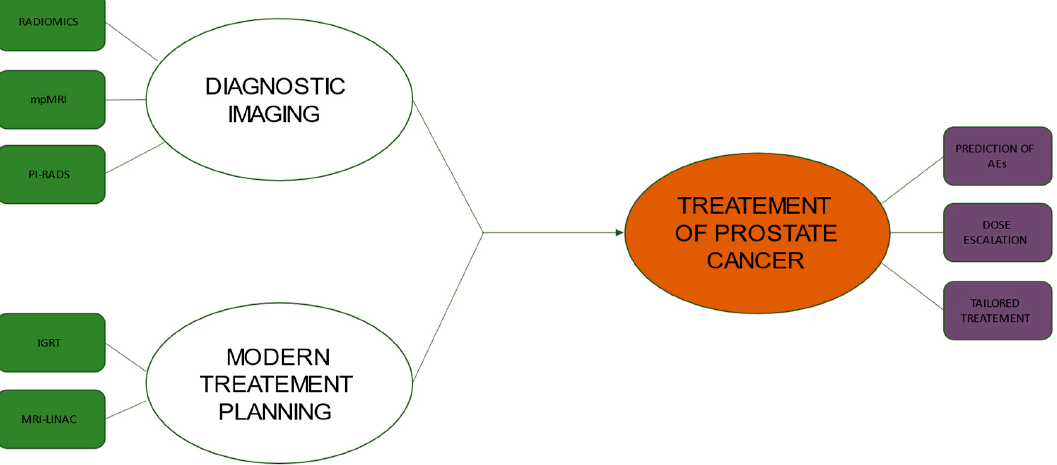
Figure 1. Flowchart showing the relationship between new diagnostic imaging technologies and modern treatment planning in the management of prostate cancer. ABBREVIATIONS: mpMRI, multi-parametric Magnetic Resonance Imaging; PI-RADS, Prostate Imaging – Reporting and Data System; IGRT, Image-Guided Radiation Therapy; MRI-LINAC, Magnetic Resonance Imaging Guided Linear Accelerator; AE, Adverse Events.